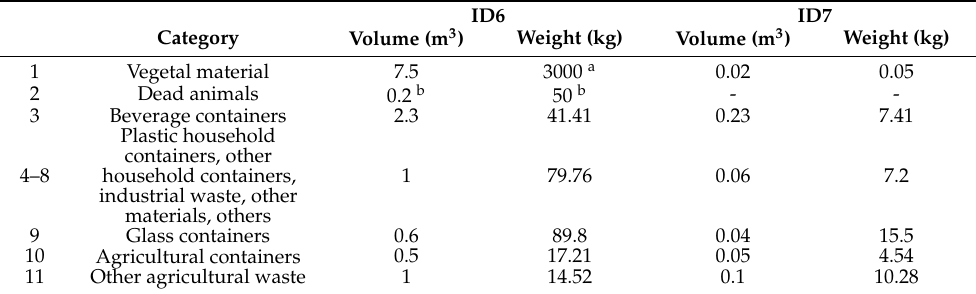
Table 3. Weights and volumes of waste extracted for calibration at sampling points ID6 (syphon